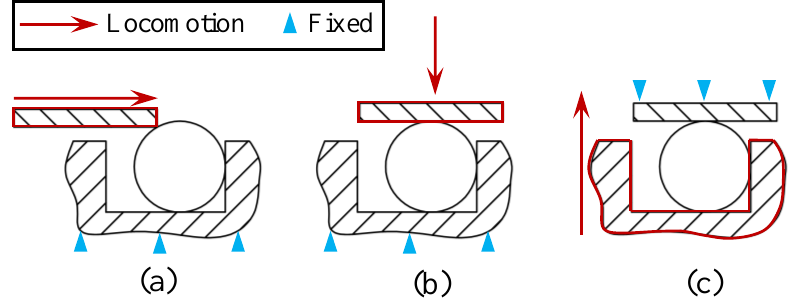
Figure 4. Modeling of installation mode. Three installation modes are used to simulate the process of pre-compression in public literature. RA mode means that the piston rod is applied with axial displacement and the groove is constraint with fixed displacement in ( a ). And RL mode means that the piston rod is applied with lateral displacement and the groove is fixed still as ( b ). The mode of GL means that the piston rod is fixed, and the groove is applied with lateral displacement in ( c ).